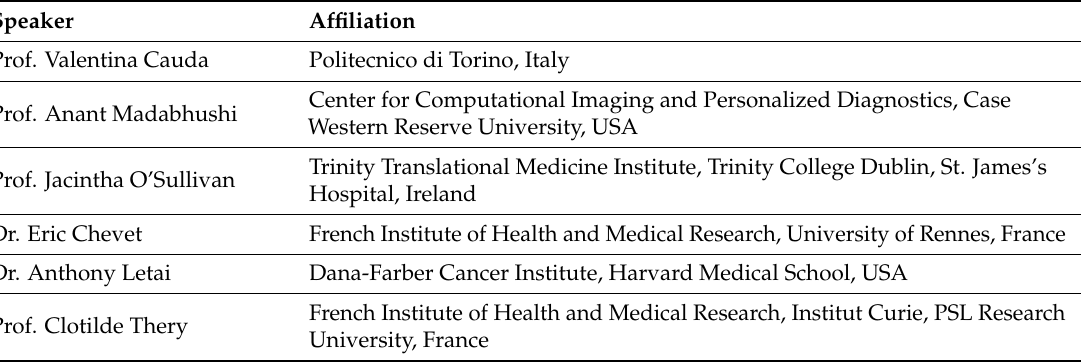
Table A1. Contributing